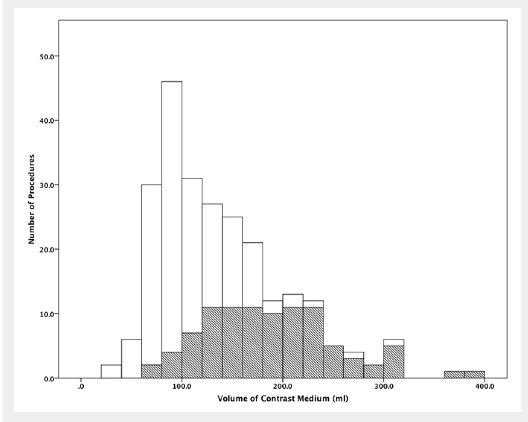
Distribution of the volume of contrast medium used for diagnostic (white areas) and for therapeutic (dashed areas) percutaneous coronary procedures.